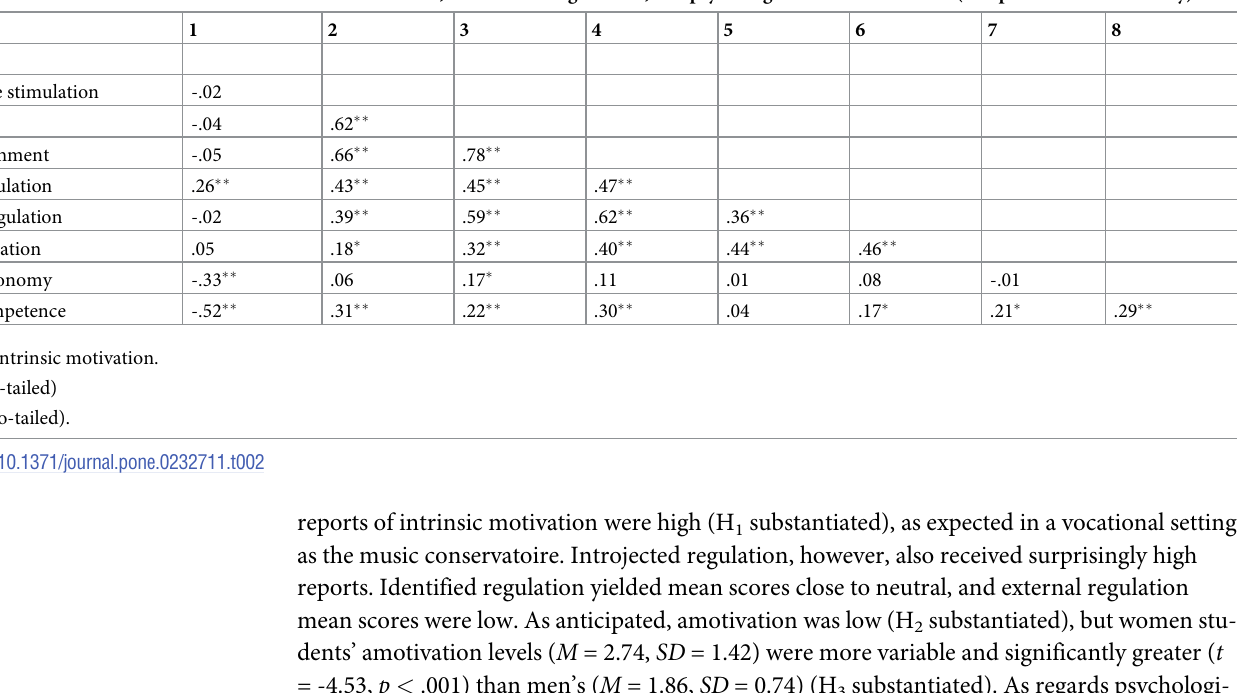
Table 2. Correlations between conservatoire students’ amotivation, behavioural regulations, and psychological needs satisfaction (competence and